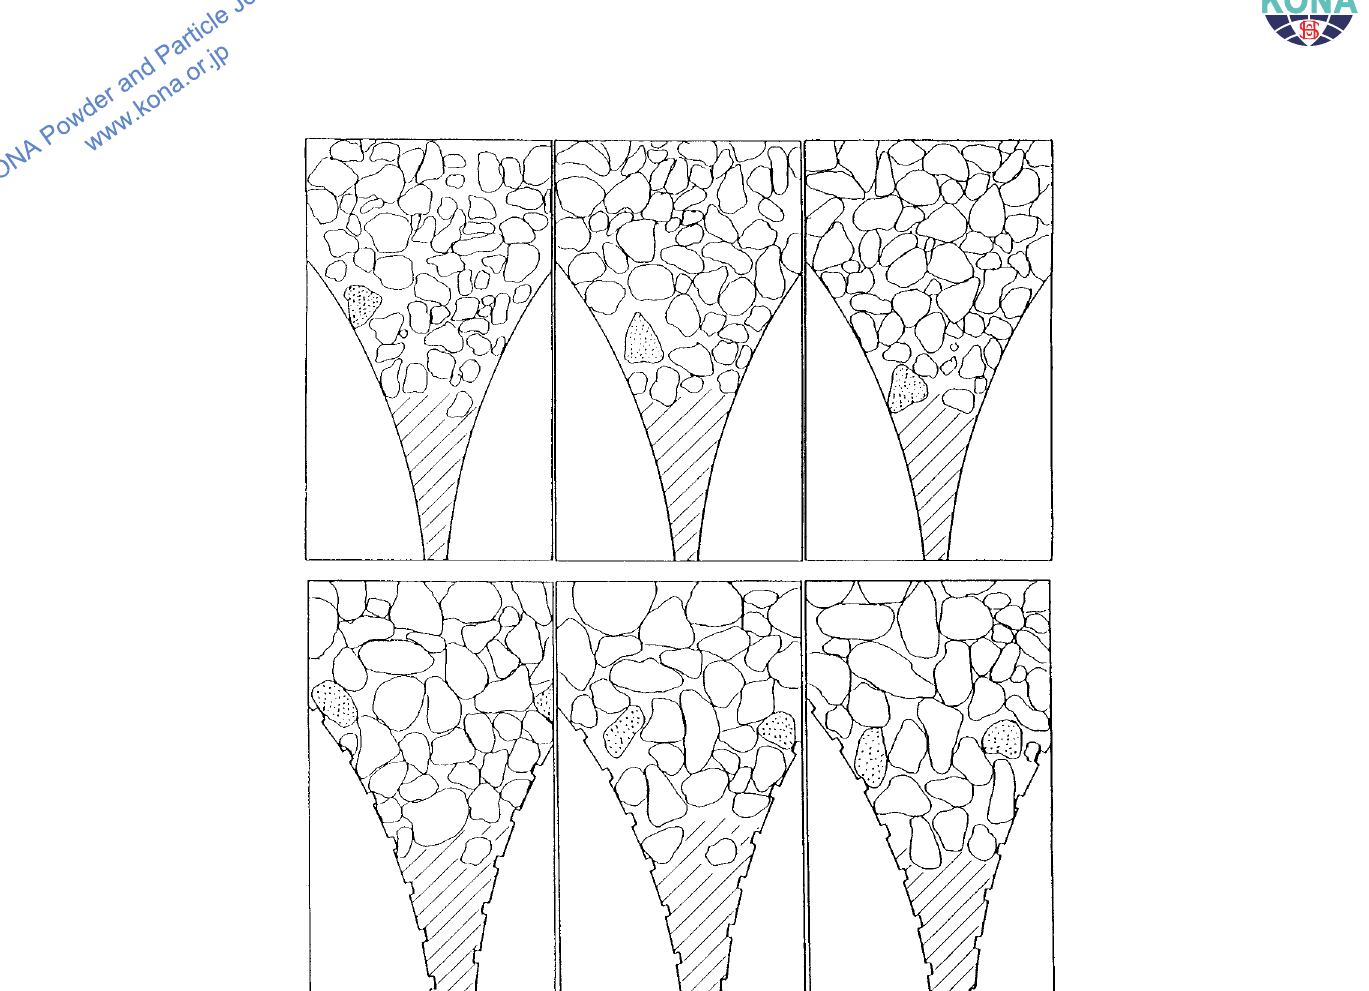
Fig.6 Movement of particles in the acceleration zone, sketches from two high speed films( 1000 frames per second). time distance about 20 ms. for details see text